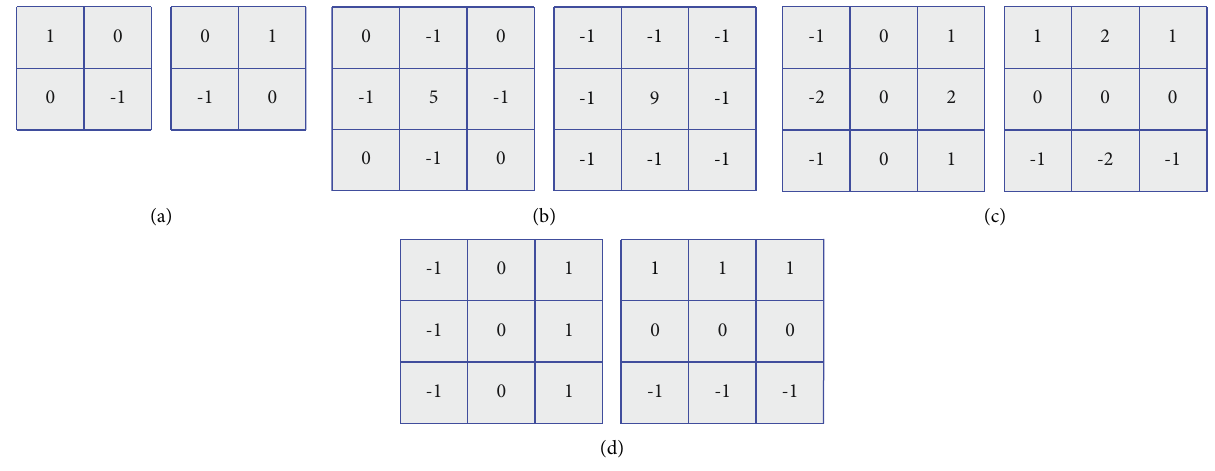
Figure 9: Commonly used edge sharpening templates.